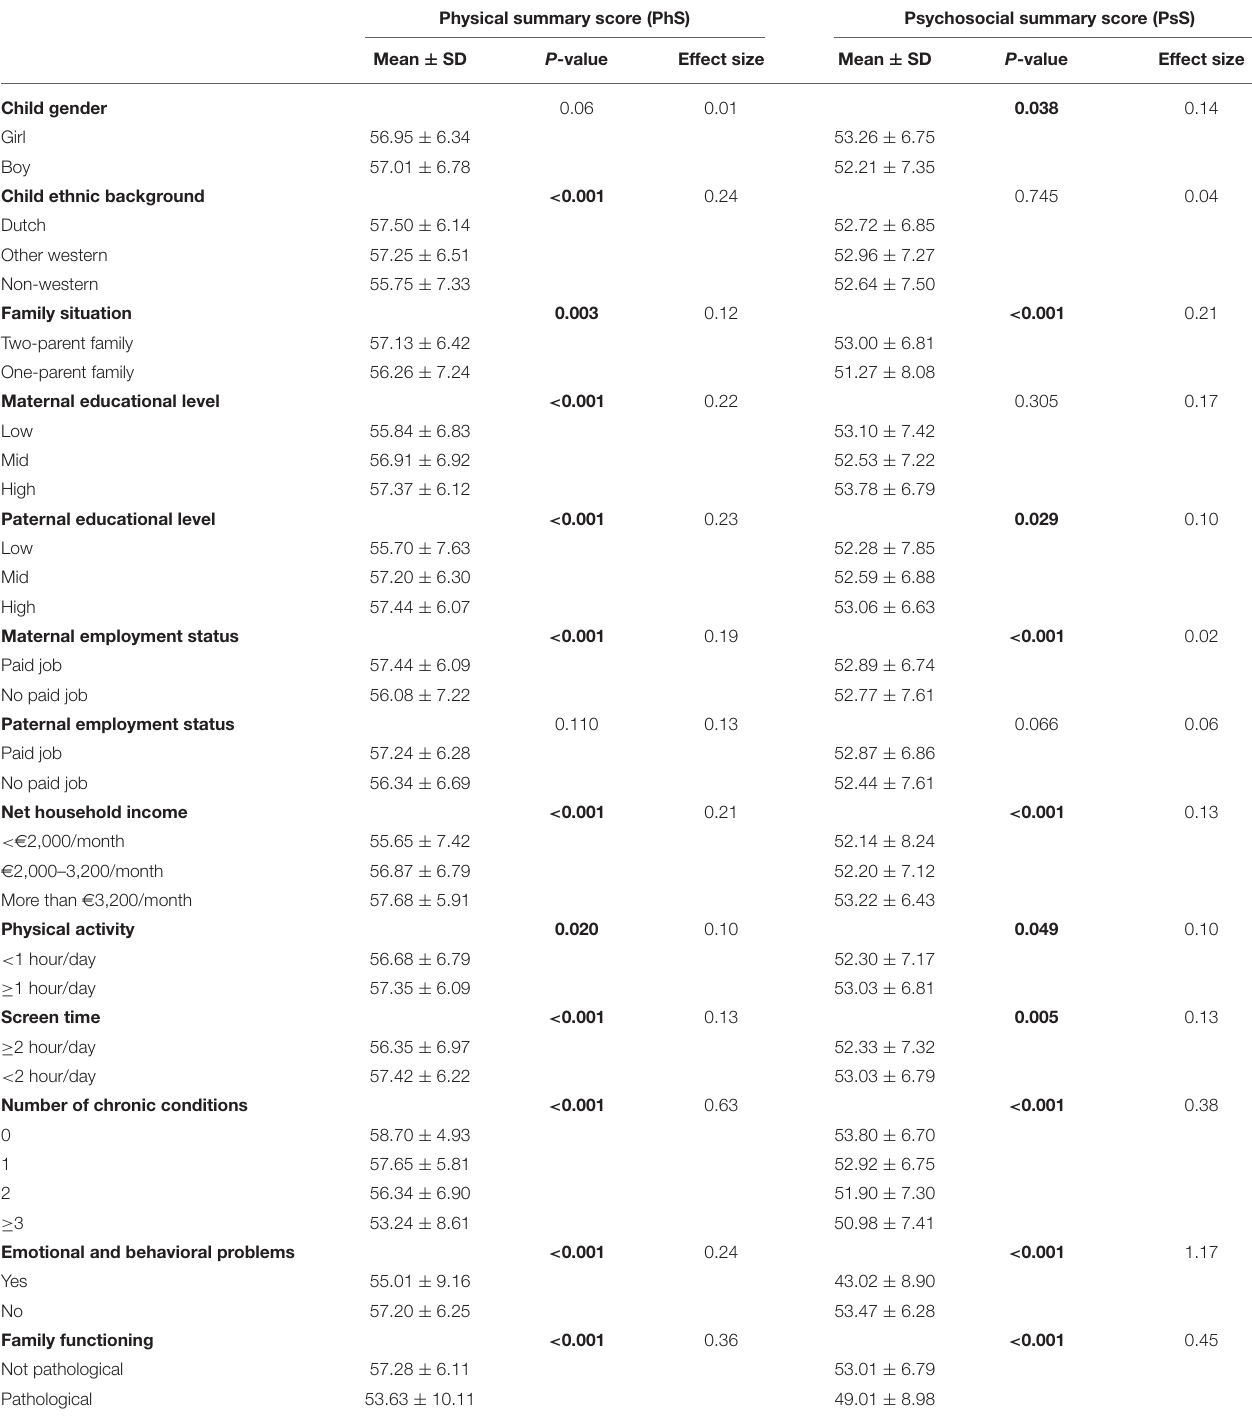
The table is based on a non-imputed dataset. P-value are calculated by independent T tests or one-way ANOVA. Effect size calculated by dividing the difference in mean scores between subgroups by the largest standard deviation and interpreted as: 0.2 ≤ effect size ≤ 0.5 small difference, 0.5 ≤ effect size ≤ 0.8 moderate difference, and effect size ≥ 0.8 large difference. Bold values indicate statistical